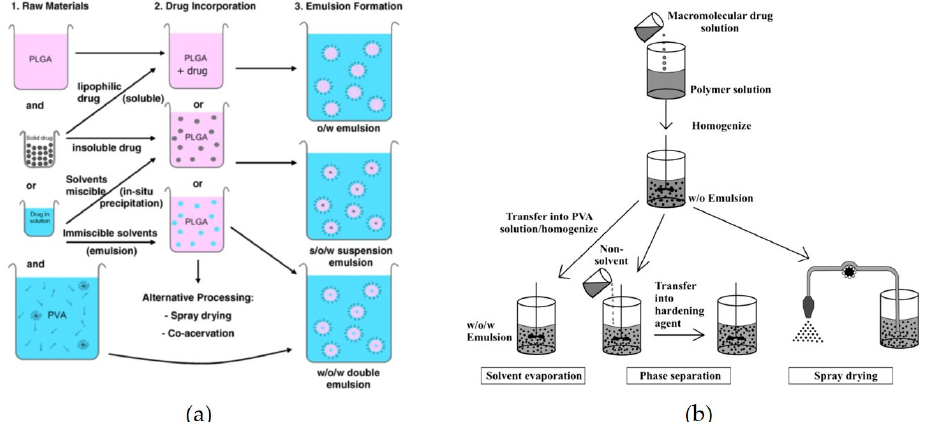
Figure 2. Strategies for emulsion-based micro-/nanoparticle formation: ( a ) emulsion preparation process (reprinted from [25] with permission, copyright Elsevier 2009) and ( b ) solidification process via solvent removal (reprinted from [6] with permission, copyright Elsevier 2008).